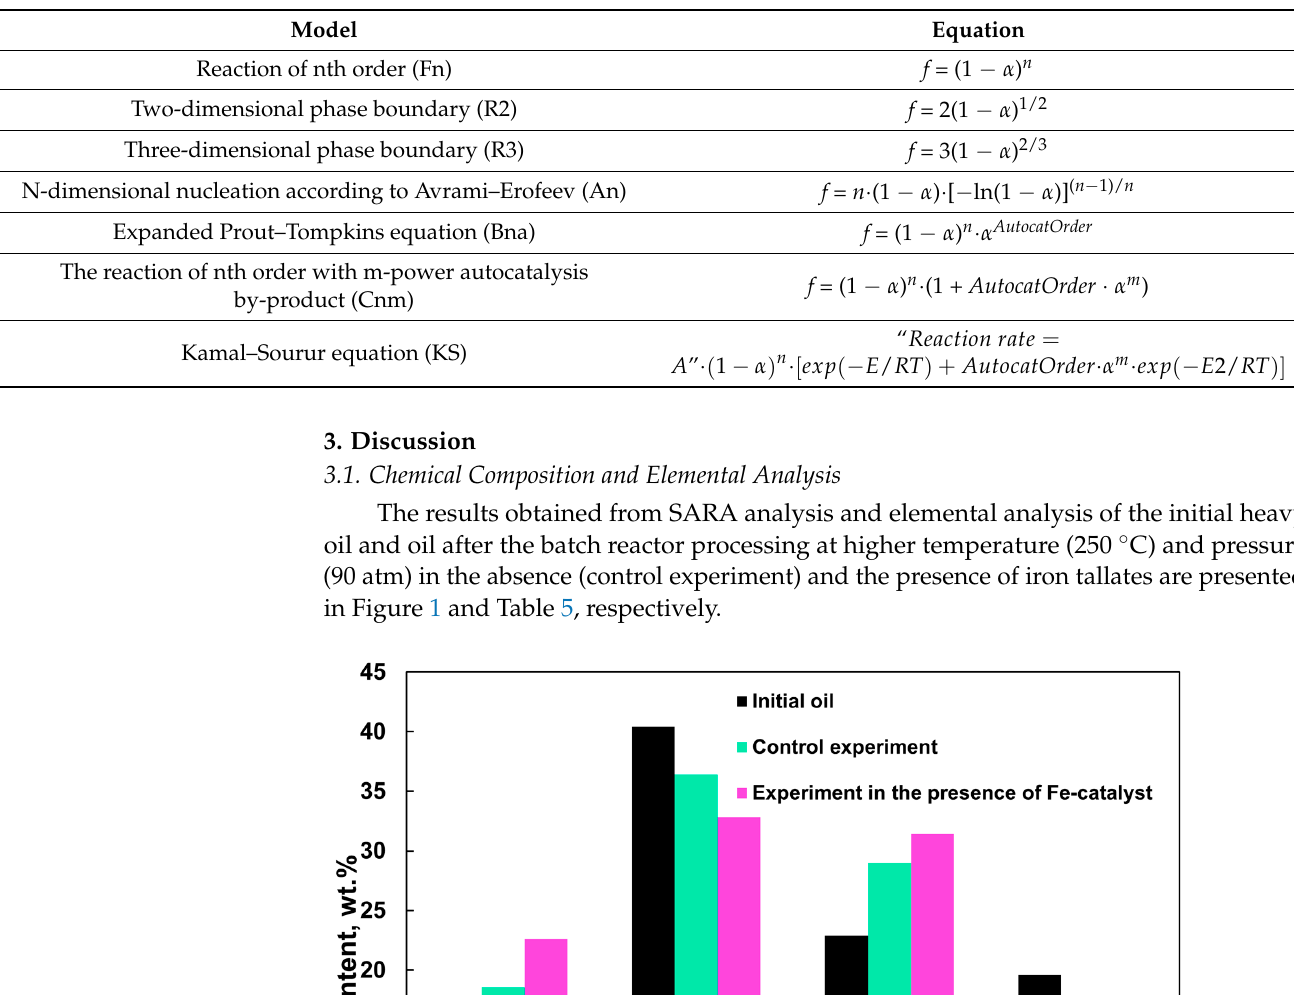
Table 4. Models’ methods for calculating kinetic parameters.